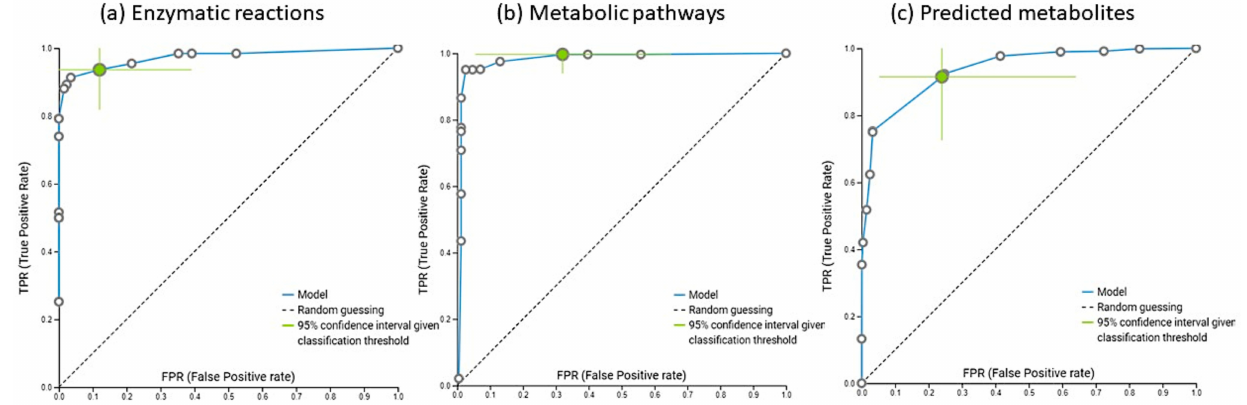
Figure 4. ROC curves of obtained models (JADBio [57]) based on the enzymatic reactions ( a ), metabolic pathways ( b ) and relaxation network predicted metabolites ( c ) produced by our in-house implementation of